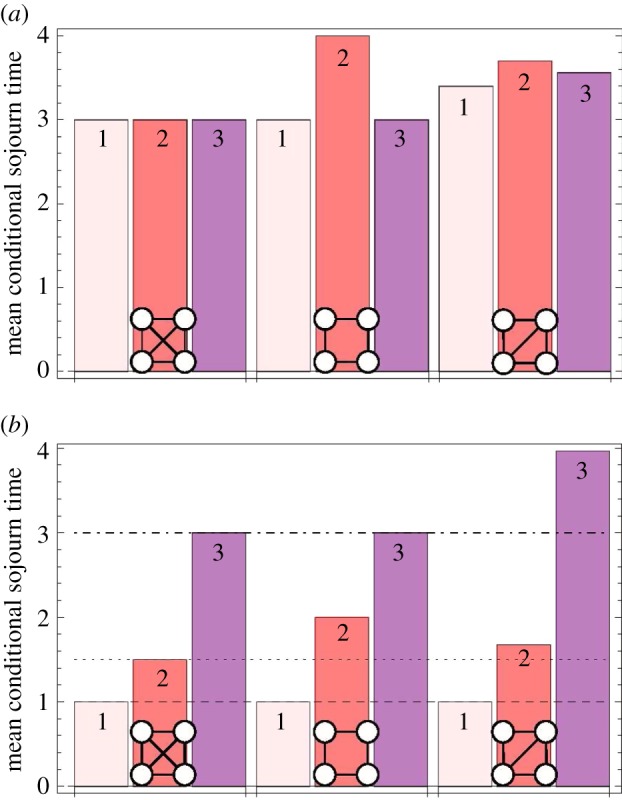
(a) The expected conditional sojourn time for neutral selection (r = 1) on the complete graph, the ring and the diamond. (b) The expected conditional sojourn time for strong selection (r → ∞). The numbers on the bars indicate the number of mutants. Note that on the diamond there are several different states for each number of mutants and only the sum of the sojourn times in those states is shown here. (Online version in colour.)